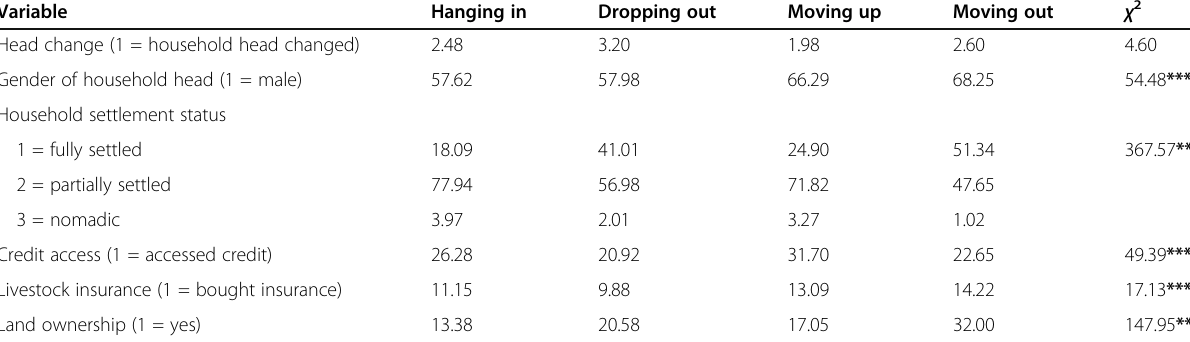
Table 4 Summary statistics (percentages) for discrete and dummy variables by livelihood pathways Variable Hanging in Dropping out